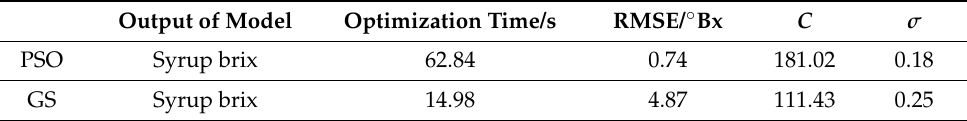
Figure 7. GS–SVR parameter selection diagram (contour map). Table 5. Parameter optimization result of SVR model.